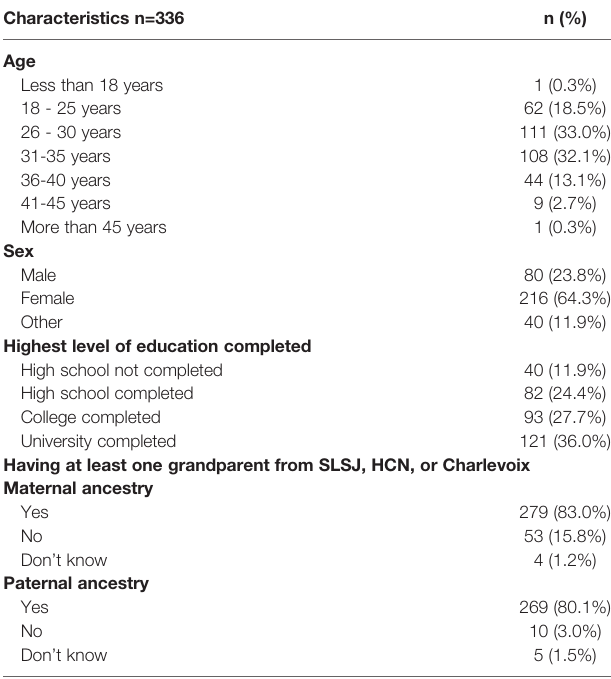
TABLE 2 | Characteristics of the participants that completed the survey on VDDR1A newborn screening